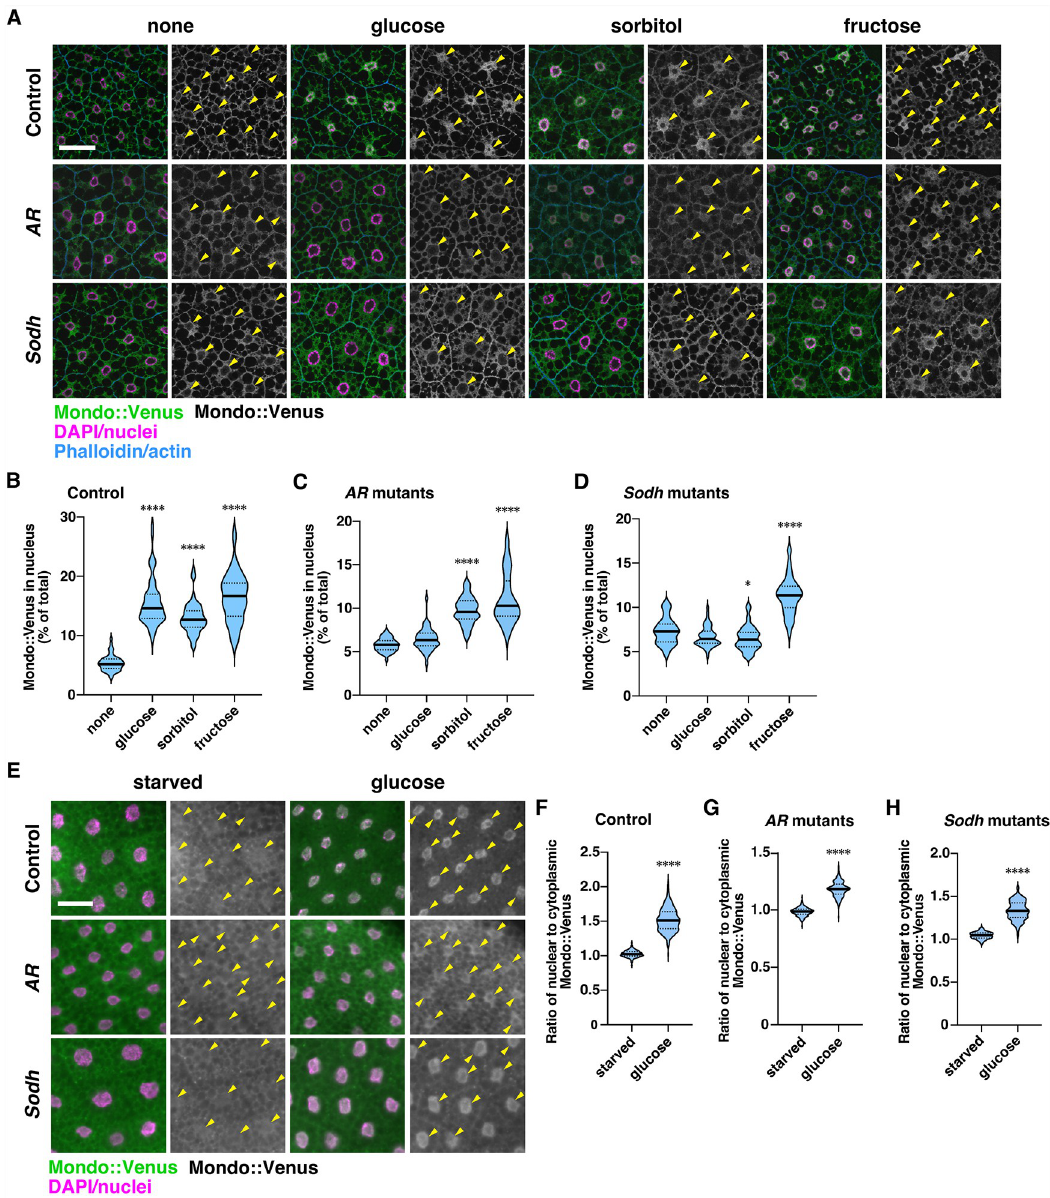
Fig 4. The polyol pathway regulates nuclear localization of Mondo. ( A ) Fat bodies dissected from normally fed Mondo::Venus knockin larvae were cultured in Schneider’s Drosophila medium supplemented with 55 mM glucose, sorbitol, or fructose for 15 minutes. After culture, the fat bodies were fixed and stained with the following markers: anti-GFP antibody for Mondo::Venus (green), DAPI (magenta), and Rhodamine-conjugated phalloidin (blue). Single-channel images of the Venus signals are shown, with nuclei indicated by arrowheads. ( B–D ) The percentage of nuclear Mondo::Venus signal out of the total Mondo::Venus signal in a cell was quantified in the images. Solid and dotted lines in the graph show the median and quartiles, respectively. Images of 49 to 56 fat body cells per experiment were quantified. ( E ) Mondo::Venus larvae were starved for 18 hours then refed with 10% glucose for 1 hour. The localization of Mondo::Venus in the fat body cells was detected by Venus fluorescence (green), and nuclei were labeled with DAPI (magenta). Single-channel images of the Venus signals are shown, with nuclei indicated by arrowheads. ( F–H ) The ratio of average intensity of Mondo::Venus signals detected in the nucleus and cytoplasm in fat body cells. Solid and dotted lines in the graph show the median and quartiles, respectively. Images of 203 to 332 fat body cells per experiment were quantified. Scale bars in (A) and (E) represent 50 μ m. � P < 0.05; ���� P < 0.0001. The data underlying the graphs can be found in S1 Data . AR, aldose reductase; Sodh, sorbitol